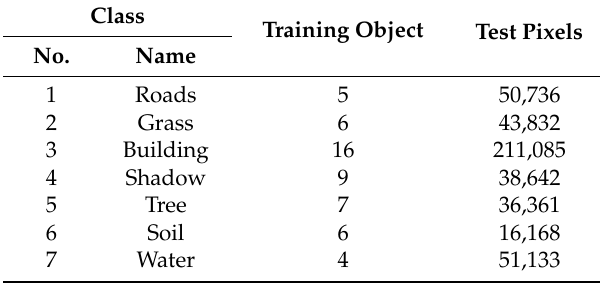
Table 3. Number of training and test data for aerial imagery.